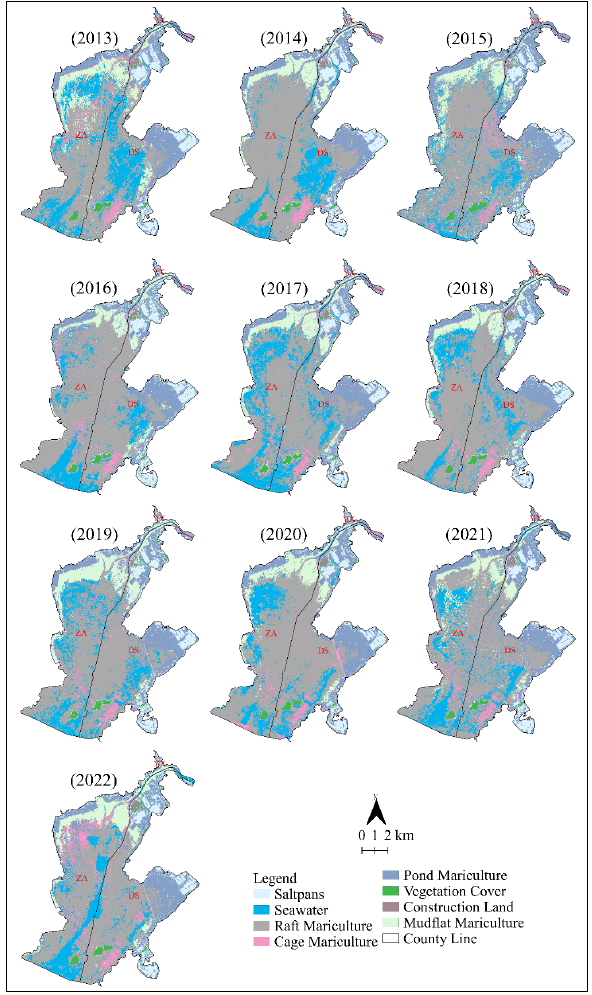
Figure A1. Map highlighting the distribution of mariculture types in the study area from 2013 to 2022 based on remote sensing data.